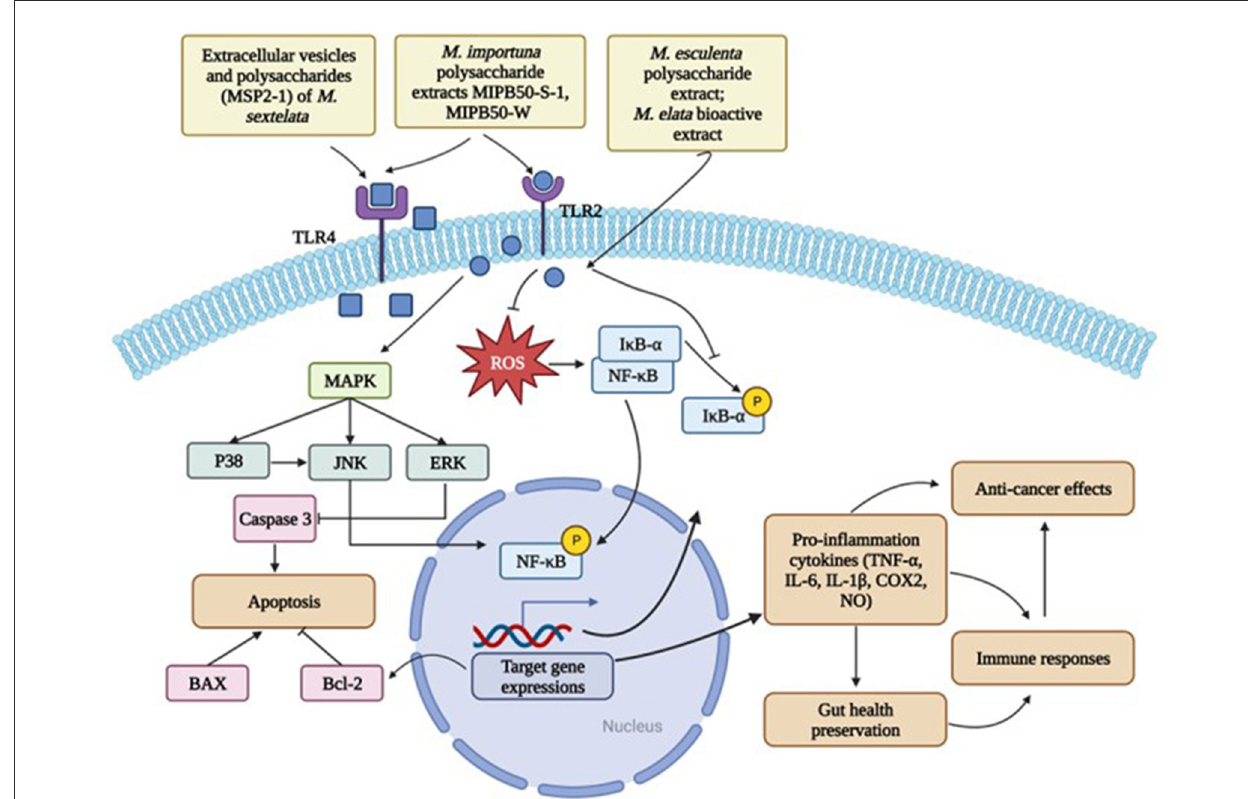
FIGURE3 Major cell signaling mechanisms of morel extracts in disease prevention. Created with BioRender.com.